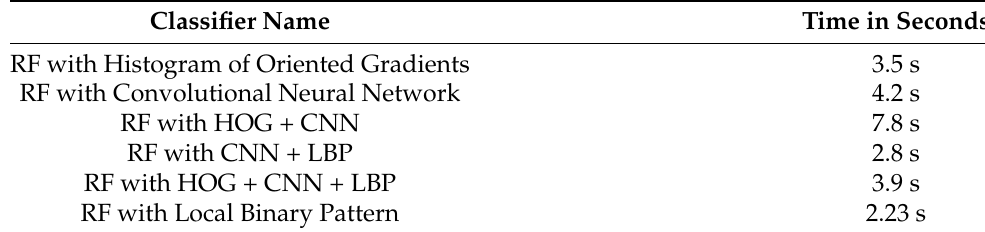
Table 3. Execution Time by RF Classifier Using LBP, CNN, and HOG.